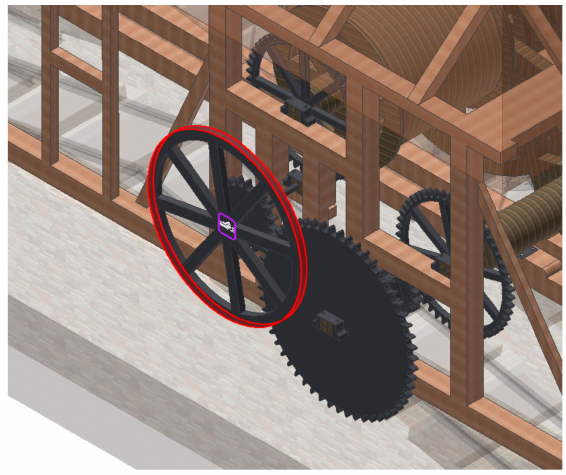
Figure 12. Fixed constraint for the inertia flywheel of the DD shaft in the blockage